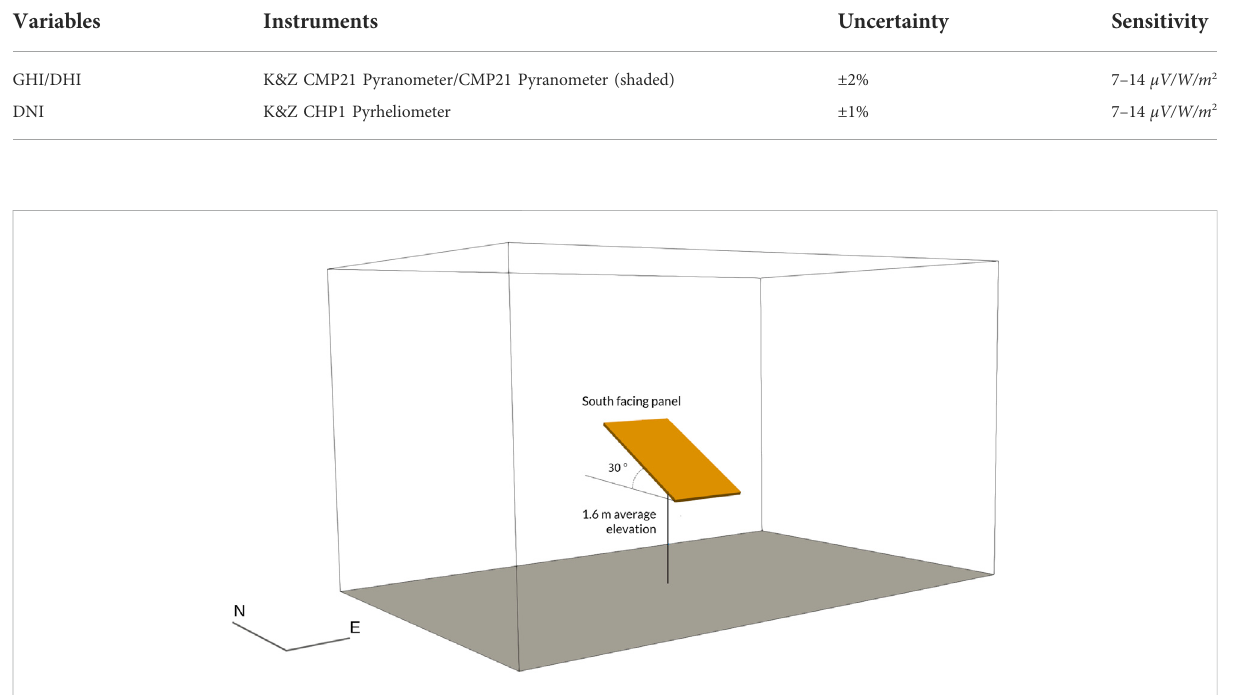
FIGURE 1 Computational domain considered in the